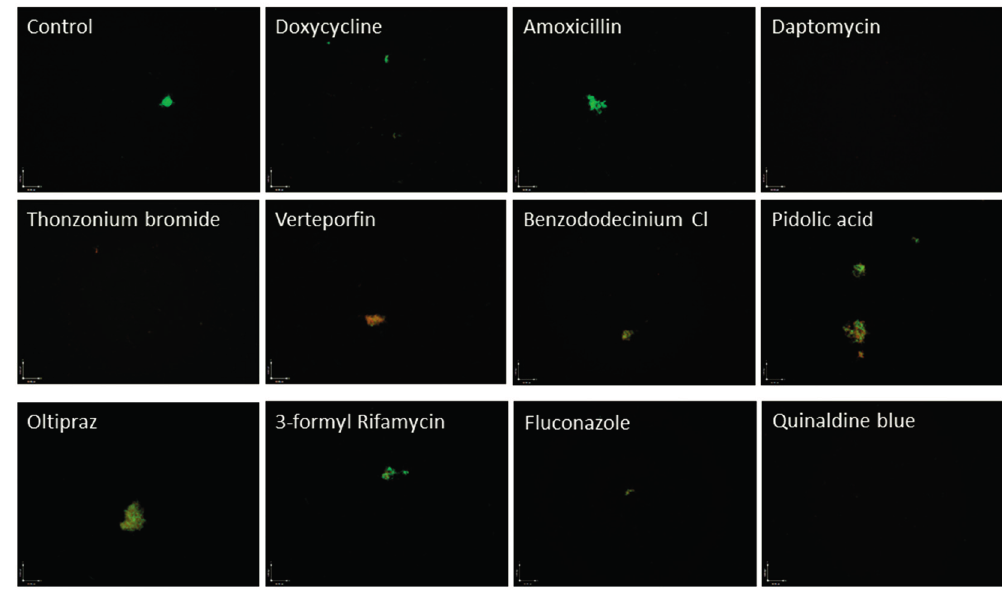
Figure 1. Image of B. burgdorferi stationary phase culture (seven day old) incubated for seven days with the indicated drugs, stained by SYBR Green I/PI assay, and examined using epifluorescence microscopy. Live cells are indicated by green fluorescence and dead cells are indicated by red